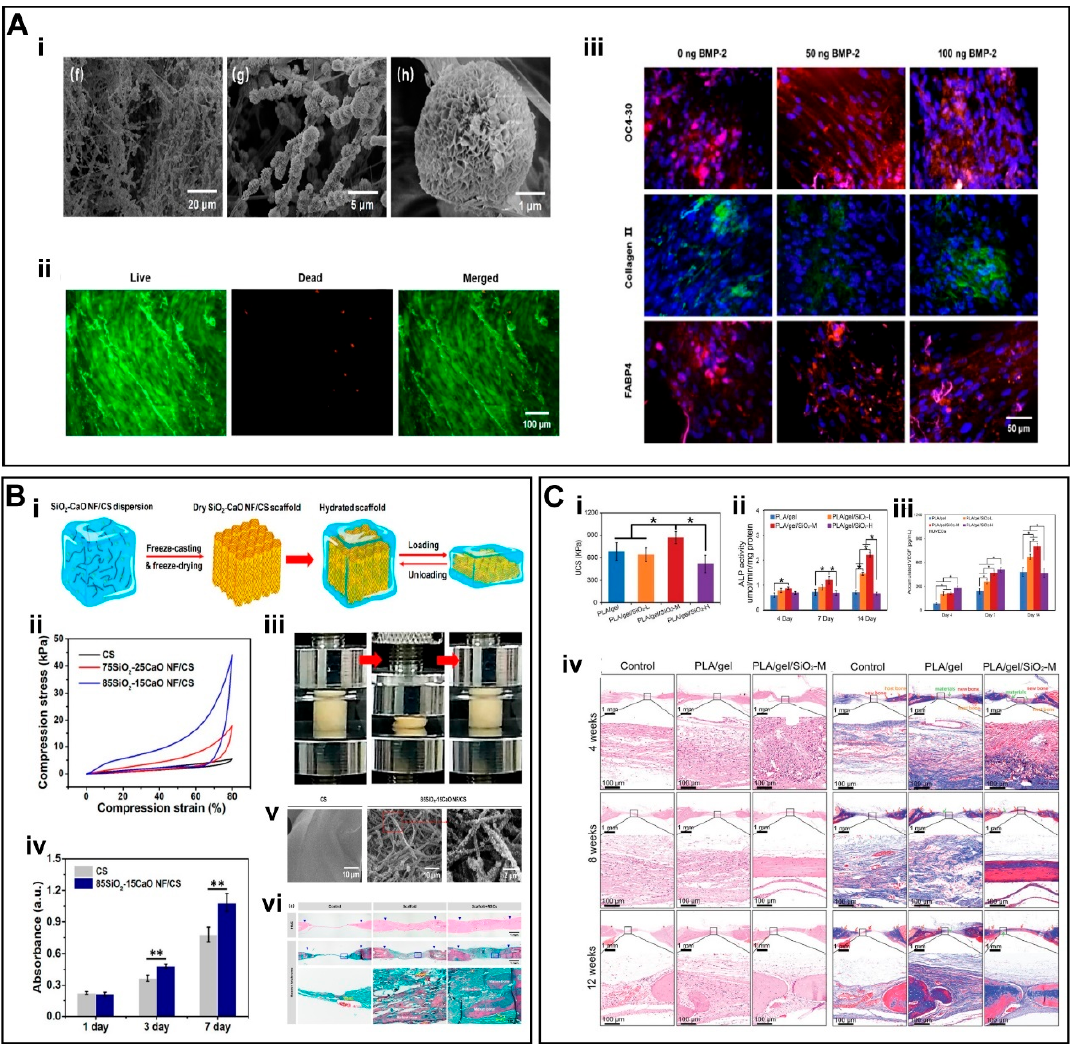
Figure 4. ( A ) (i) SEM images of mineralized SiO 2 NF/CS matrices. (ii) Live/dead staining assay of hMSCs. (iii) IF staining of scaffolds by using OC4-30, collagen II, and FABP4. ( B ) (i) Schematic illustration of the fabrication of 3D SiO 2 -CaO NF/CS scaffold. (ii) Compression curves. (iii) Shape recovery of scaffold in aqueous medium. (iv) Cell viability of MSCs. (v) SEM photomicrographs of in situ mineralized scaffolds. (vi) H&E and Masson’s trichrome staining of scaffolds. ( C ) (i) UCS of scaffolds under dry conditions. (ii) Alkaline phosphatase (ALP) activity of scaffolds. (iii) Cumulative release of VEGF. (iv) H&E staining and Masson’s trichrome staining of scaffolds. ( A ) (i–iii) Reproduced with permission from Ref. [83]. Copyright 2020 Elsevier Inc. ( B ) (i–vi) Reproduced with permission from Ref. [86]. Copyright 2019 American Chemical Society. ( C ) (i–iv) Reproduced with permission from Ref. [64]. Copyright 2022 Wiley-VCH